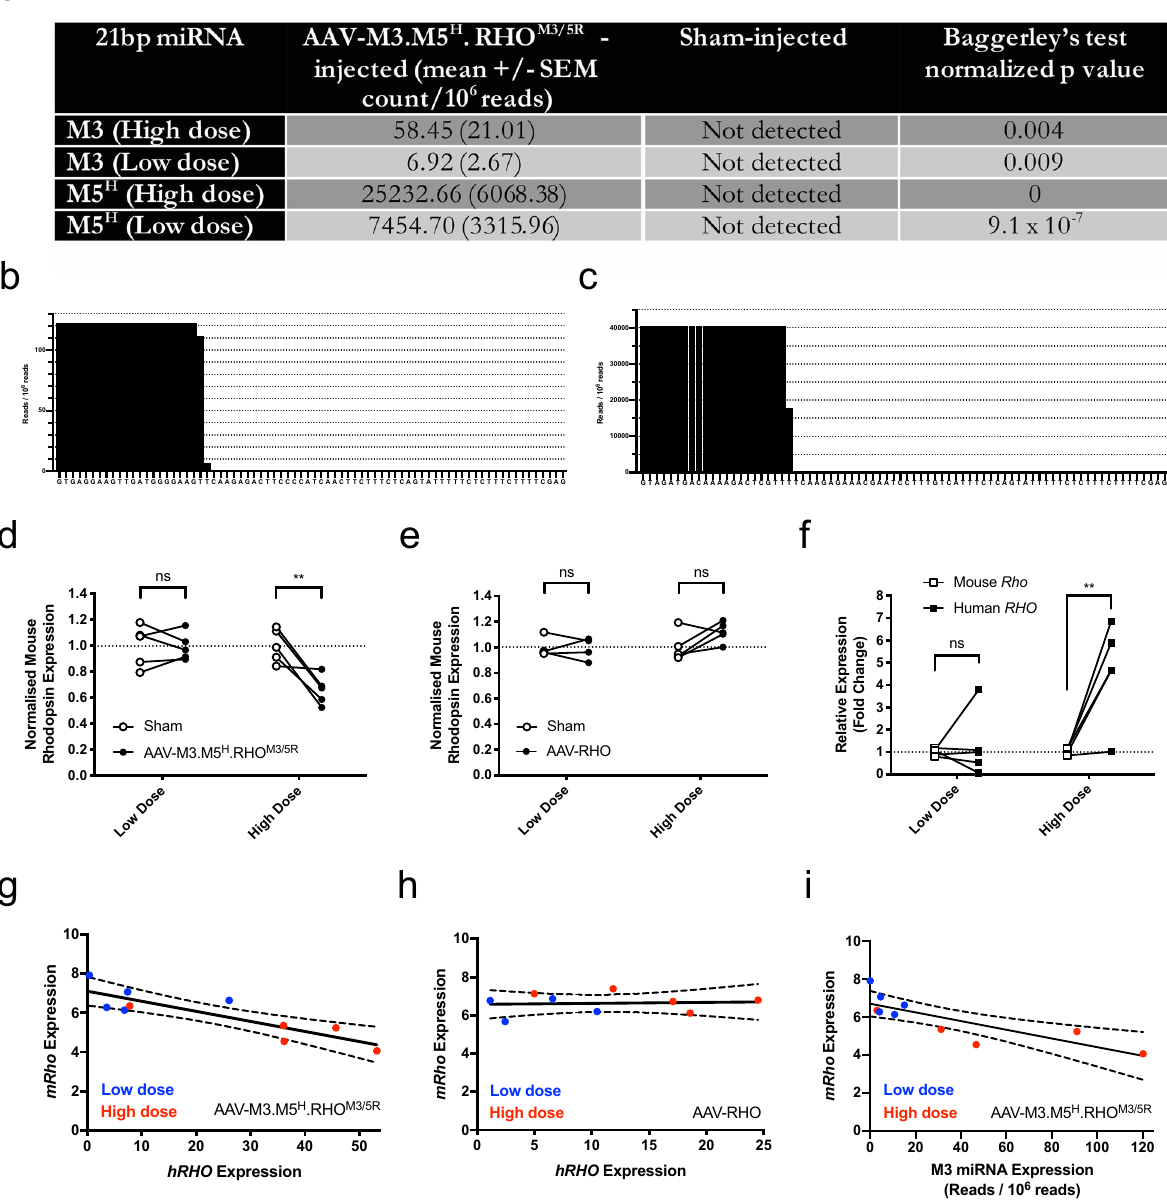
Fig. 5 Micro RNA expression and gene expression analysis of knockdown and replacement arms of AAV-M3.M5 H .RHO M3/5R gene therapy 4 weeks after subretinal injection in the Nrl.GFP/ + , Rho P23H/ + mouse. Gene expression levels refer to the ratio Rhodopsin: eGFP (note eGFP expression is rod- speci fi c in this model 36 ). a Small RNA expression analysis detected mirtron-derived 21 bp mature miRNAs corresponding to Mirtron 3 (M3) and Mirtron 5 H (M5 H ) guide sequences in AAV-injected but not in sham-injected eyes. b Short RNA sequencing (15 – 31 nt) from high-dose AAV-M3.M5 H .RHO M3/5R - treated retinas aligned to the Mirtron 3 sequence. c Short RNA sequencing (15 – 31 nt) from high-dose AAV-M3.M5 H .RHO M3/5R -treated retinas aligned to the Mirtron 5 H sequence. d Suppression of endogenous mouse rhodopsin gene expression by AAV-M3.M5 H .RHO M3/5R . Paired right (AAV-injected) and left (sham PBS-injected) eyes are connected by joining lines. ** p = 0.0024, two-way ANOVA, Š idák ’ s multiple comparisons test. e No suppression of endogenous mouse rhodopsin was detected at either dose in eyes injected with the mirtronless AAV-RHO vector. Paired right (AAV-injected) and left (sham PBS-injected) eyes are connected by joining lines. Two-way ANOVA, Š idák ’ s multiple comparisons test. f Human transgenic rhodopsin supplementation levels in AAV-M3.M5 H .RHO M3/5R -injected retinas expressed as fold change relative to endogenous mouse rhodopsin in fellow eyes. ** p = 0.0011, two-sided Š idák ’ s multiple comparisons test. g Scatter plot of human RHO versus mouse Rho gene expression relative to eGFP housekeeper following subretinal injection of AAV-M3.M5 H .RHO M3/5R as determined by qPCR ( r 2 = 0.731, p = 0.0016). Trend lines represent linear regression ± 95% con fi dence interval (dotted lines). h Scatter plot of human RHO versus mouse Rho gene expression relative to eGFP housekeeper following subretinal injection of AAV-RHO (mirtronless human rhodopsin vector) as determined by qPCR ( r 2 = 0.005923, p = 0.844). i Scatter plot of mouse Rho gene expression as a function of Mirton-3-derived miRNA expression in eyes receiving subretinal injection of AAV-M3.M5 H .RHO M3/5R at low (2 × 10 8 gc) and high (2 × 10 9 gc) dose ( r 2 = 0.670, p =